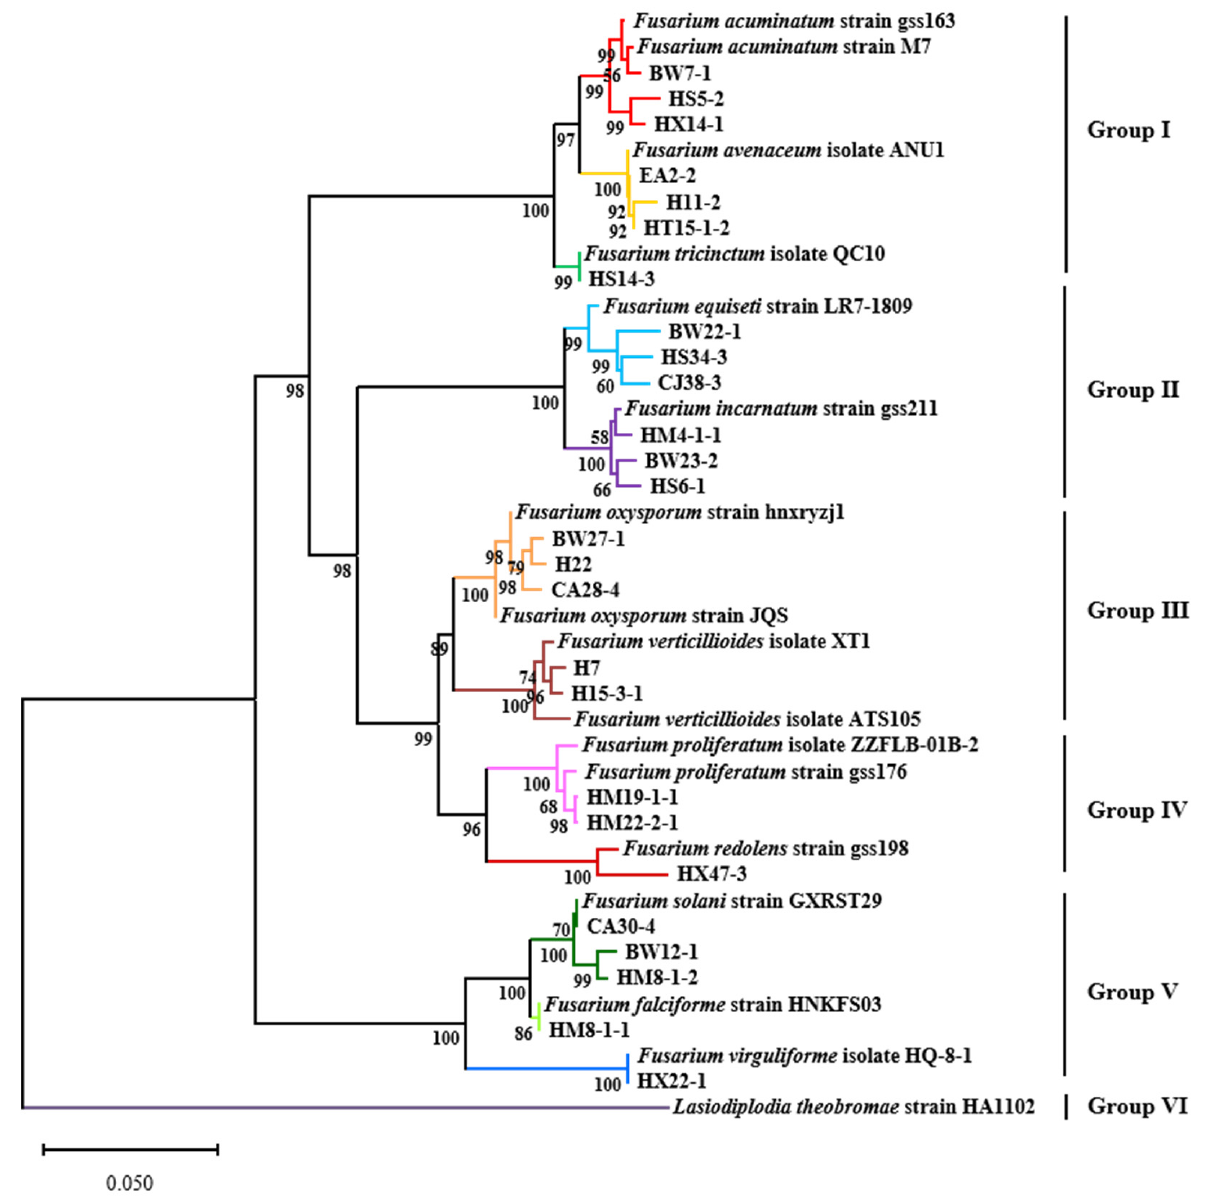
Figure 2. Phylogenetic tree based on the ITS+EF-1 α +TUB sequences of 26 representative strains and other related Fusarium species retrieved from GenBank. The Maximum likelihood method was used for tree construction using Mega (version 11.0) software. Numbers at the nodes indicate bootstrap support (percent of 1000 bootstrap replicates). L. theobromae was used as the outgroup.